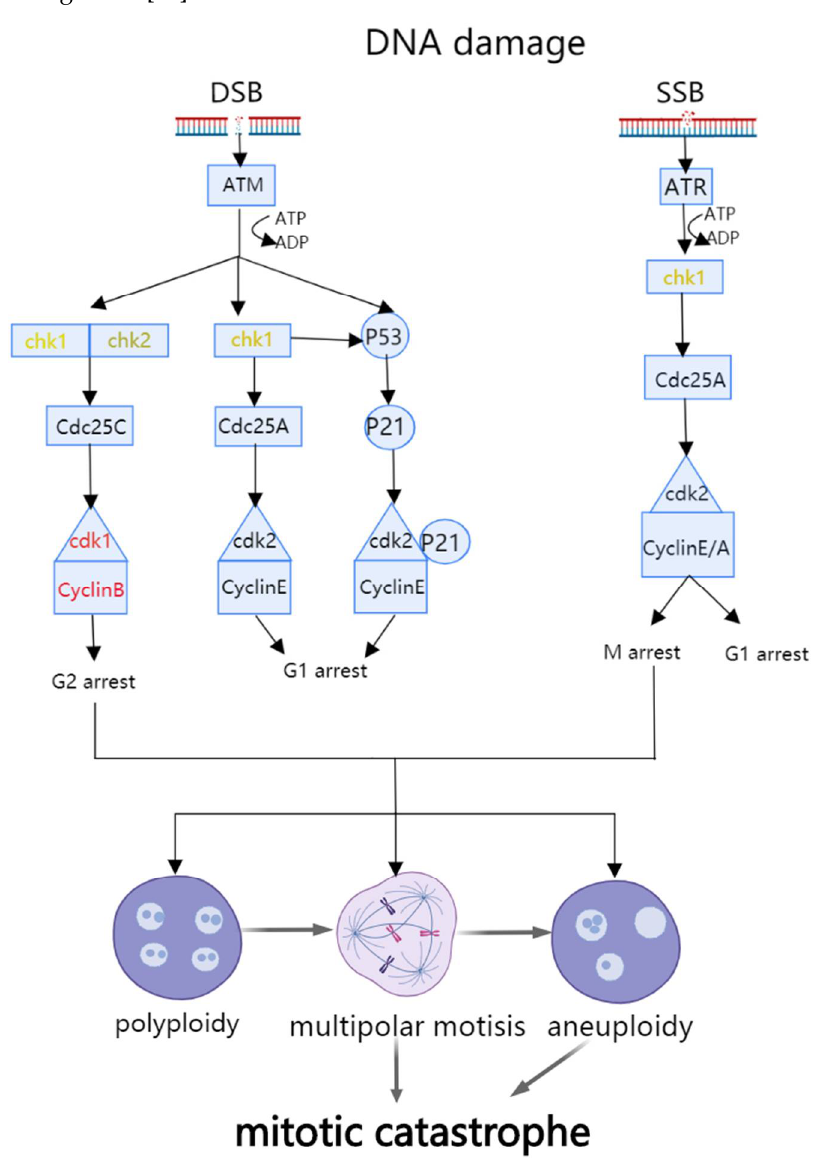
Figure 1. Schematic diagram of mitotic catastrophe